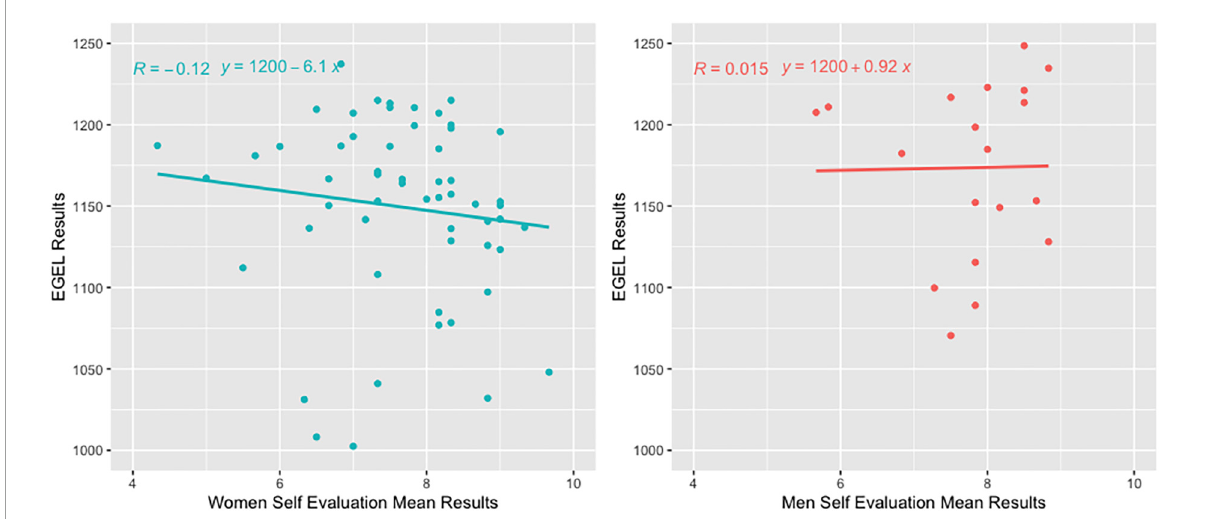
FIGURE7 EGEL (General graduation Exam by the National Centre of Evaluation) results and self-evaluation of academic categories mean results comparison by gender. The correlation coefficients for women and men were − 0.12 and 0.015, respectively.